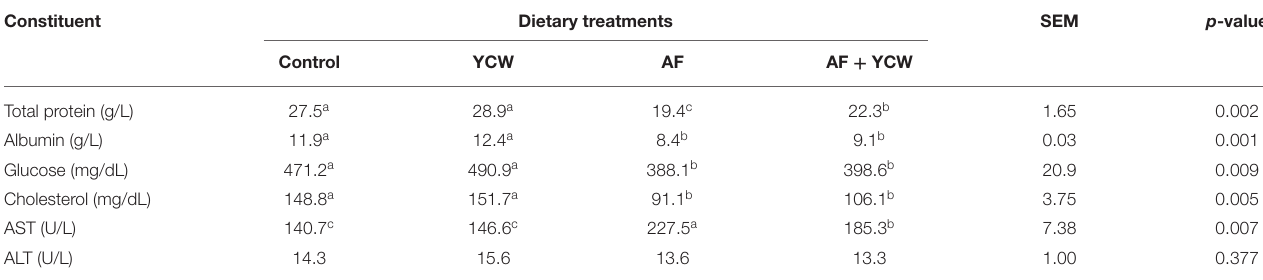
TABLE 4 | Selected serum biochemical profiles in broiler chickens at 21 days of age. Constituent Dietary treatments